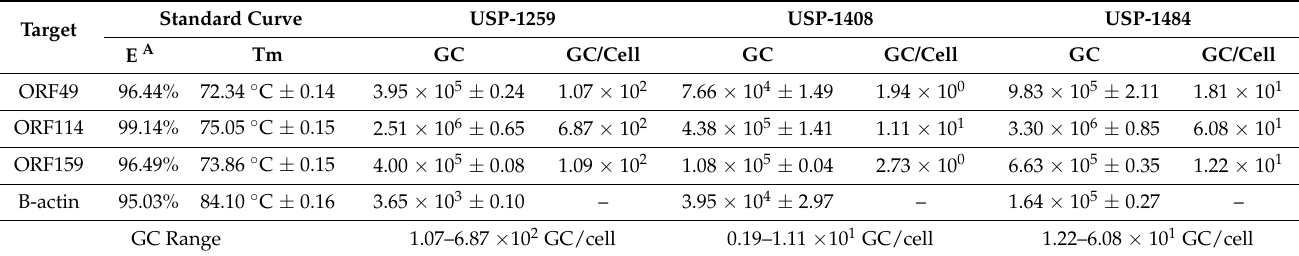
Table 3. Results of qPCR assays in studied